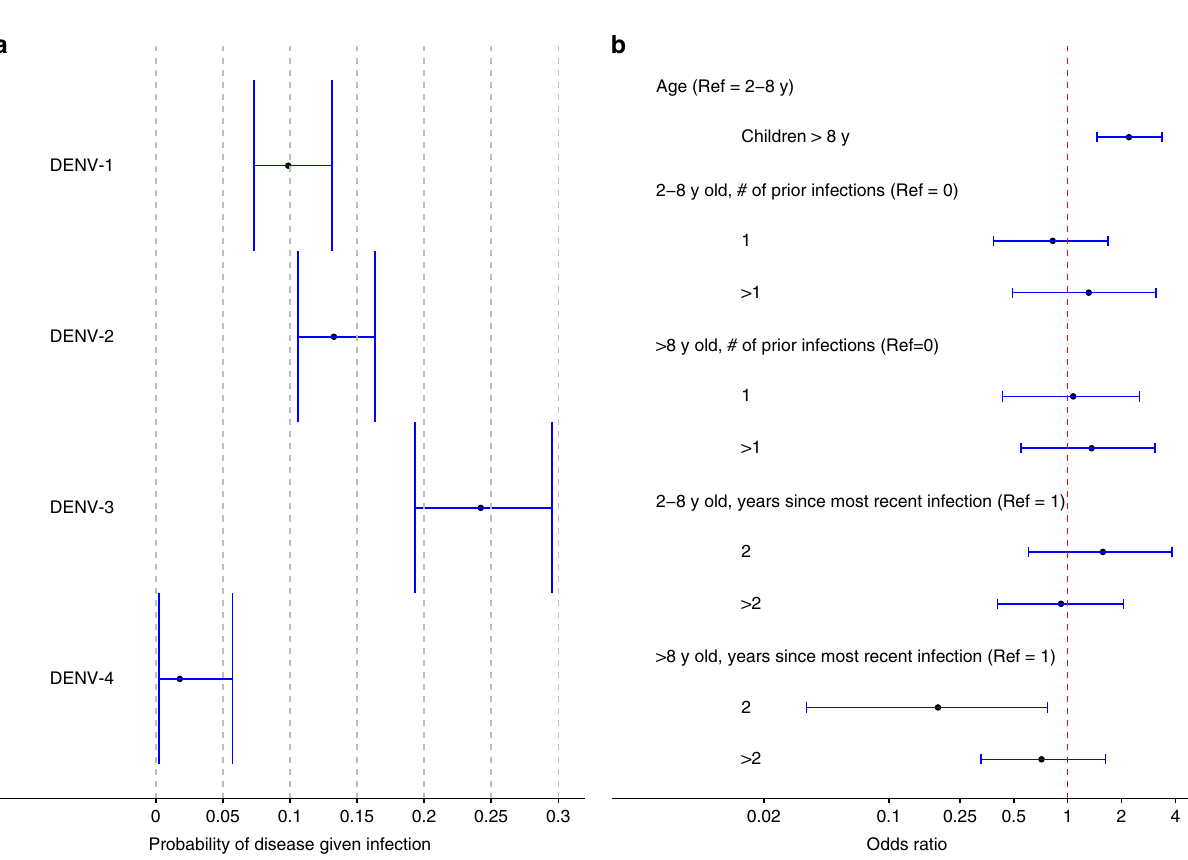
Fig. 3 Estimated probabilities of disease given infection and effects of risk factors. Points and vertical bars indicate posterior medians and 95% credible intervals. a Serotype-speci fi c probability of disease given infection. b Association of the risk of disease given infection with serostatus at entry, age group, and years since most recent infection. The reference group is children aged 2 – 8 years, without prior infection. Source data are provided as a Source Data fi